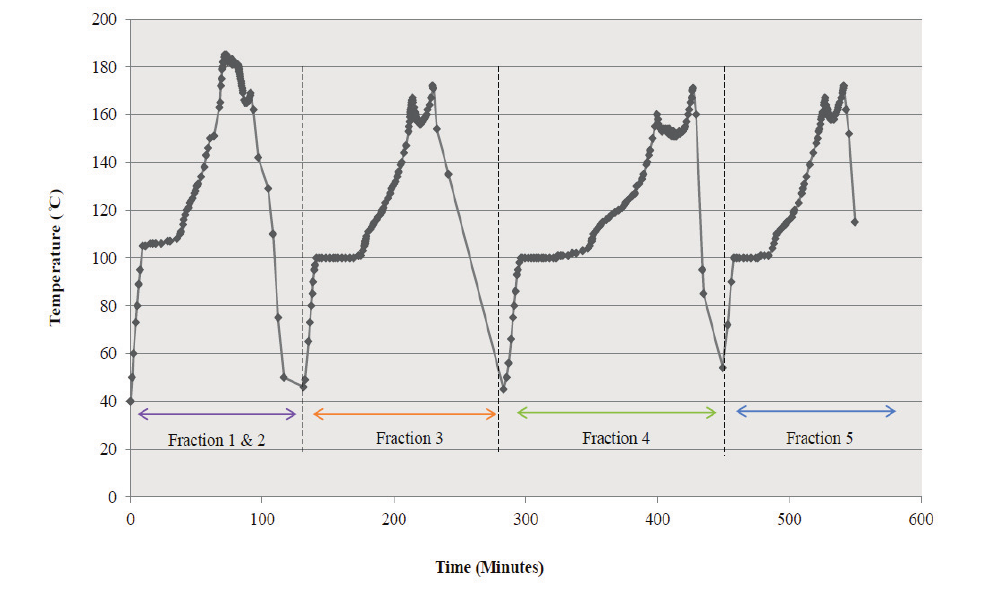
Figure 2: Distillation model for the purification process of APR.